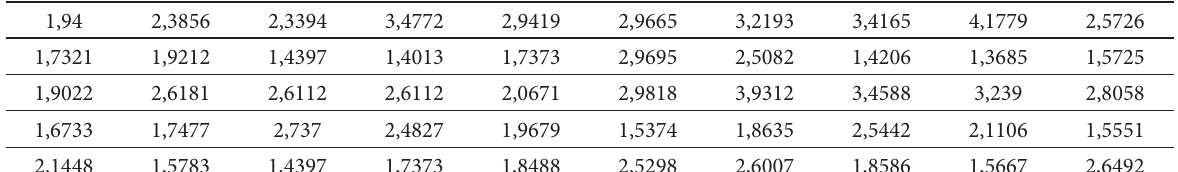
Table 1. Part of a vector of the standard deviations of the scale sections, pixels